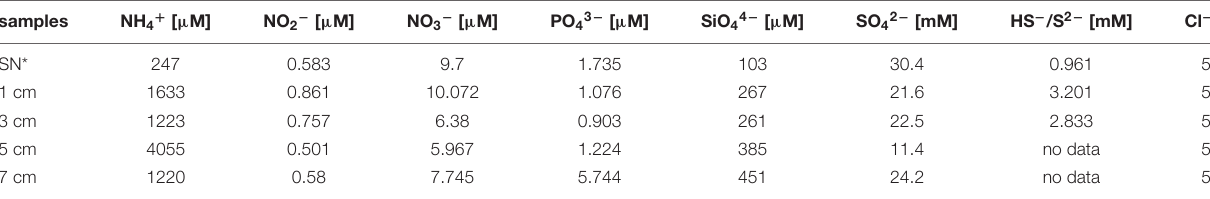
TABLE 1 | Porewater concentrations for core 4868-10.